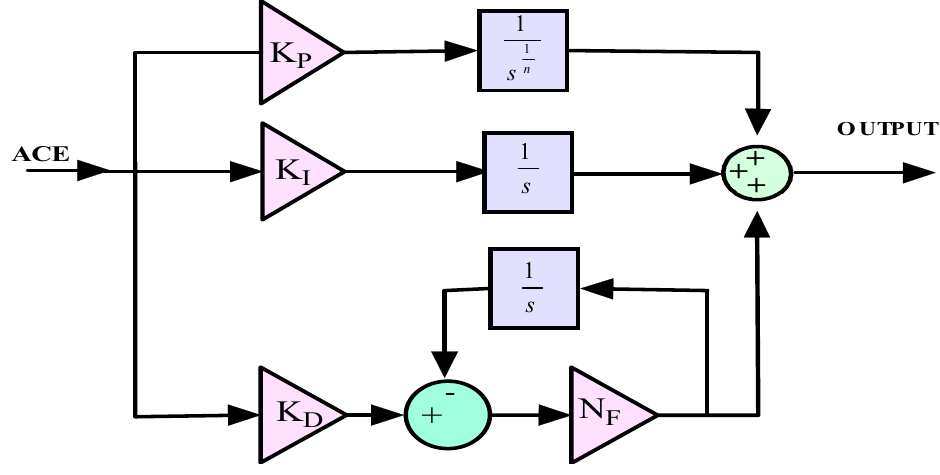
Figure 7 Tilt integral derivative controller . Figure 7. Tilt integral derivative